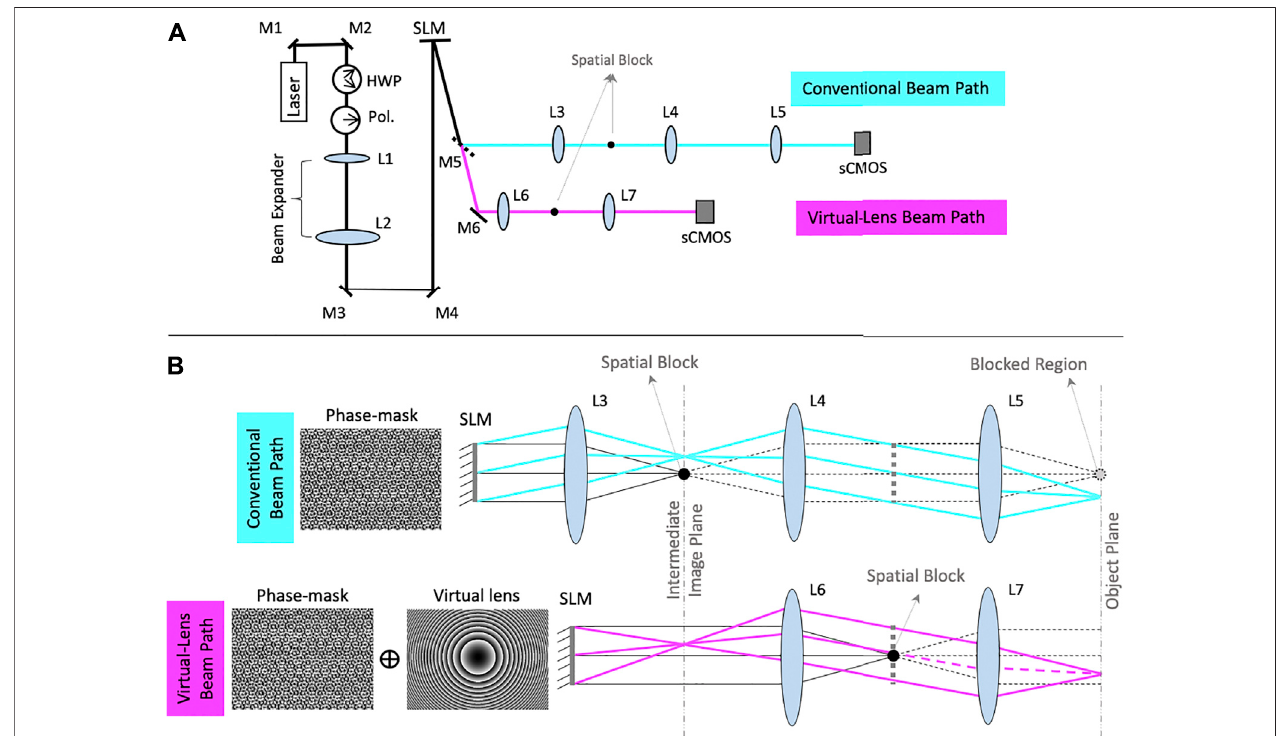
FIGURE 2 | Details of the optical path and lens arrangement. (A) Optical layout for comparison of the conventional and virtual lens con fi guration. M1 and M2 are mirrors that steer the beam into the system. The half wave plate (HWP) and polarizer (Pol.) work in concert to pass light to the SLM at its designed polarity. The set of L1 and L2 lenses expand the beam to fi ll the SLM. M3 and M4 center the beam on the SLM. M5 is a removable mirror that, when in place, re fl ects the beam to the conventionalbeampath(cyan)andwhenremoved,allowsthebeamtopasstothevirtuallensbeampath(magenta).L3,L4,andL5arethesequenceoflensesthat project the illumination pattern on the sCMOS camera on the conventional path, M6 is the mirror that in absence of M5 re fl ects the beam into the virtual lens beam path andL6andL7arethesequenceoflensesrequiredtoprojecttheilluminationpatternonthesCMOScamera.Thespatialblocksareplacedontheopticalaxesinthefront focal planes of lenses L3 and L6. (B) the ray diagram of the conventional (cyan) and virtual lens (magenta) con fi gurations. The phase masks displayed on the SLM are shown on the